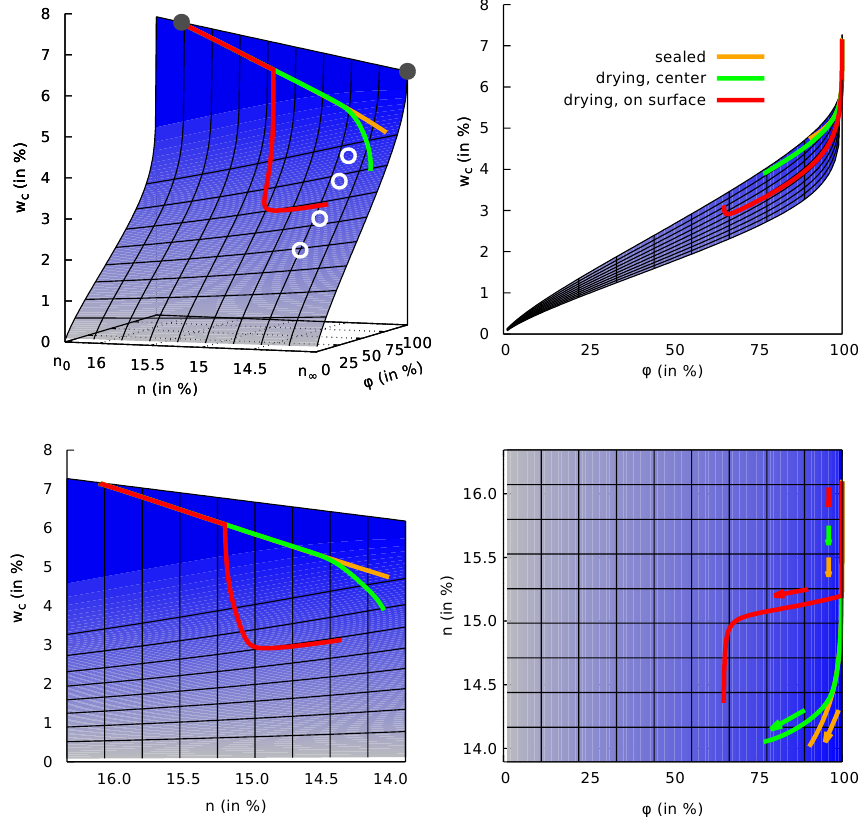
Figure 4. Three-dimensional representation of the desorption isotherm surface in terms of the mass water content w c , the porosity n and the relative humidity ϕ ( top left ); side view ( top right ); front view ( bottom left ); top view ( bottom right ). White circles indicate measured values [7,8] whereas grey circles represent estimated values according to (46) and